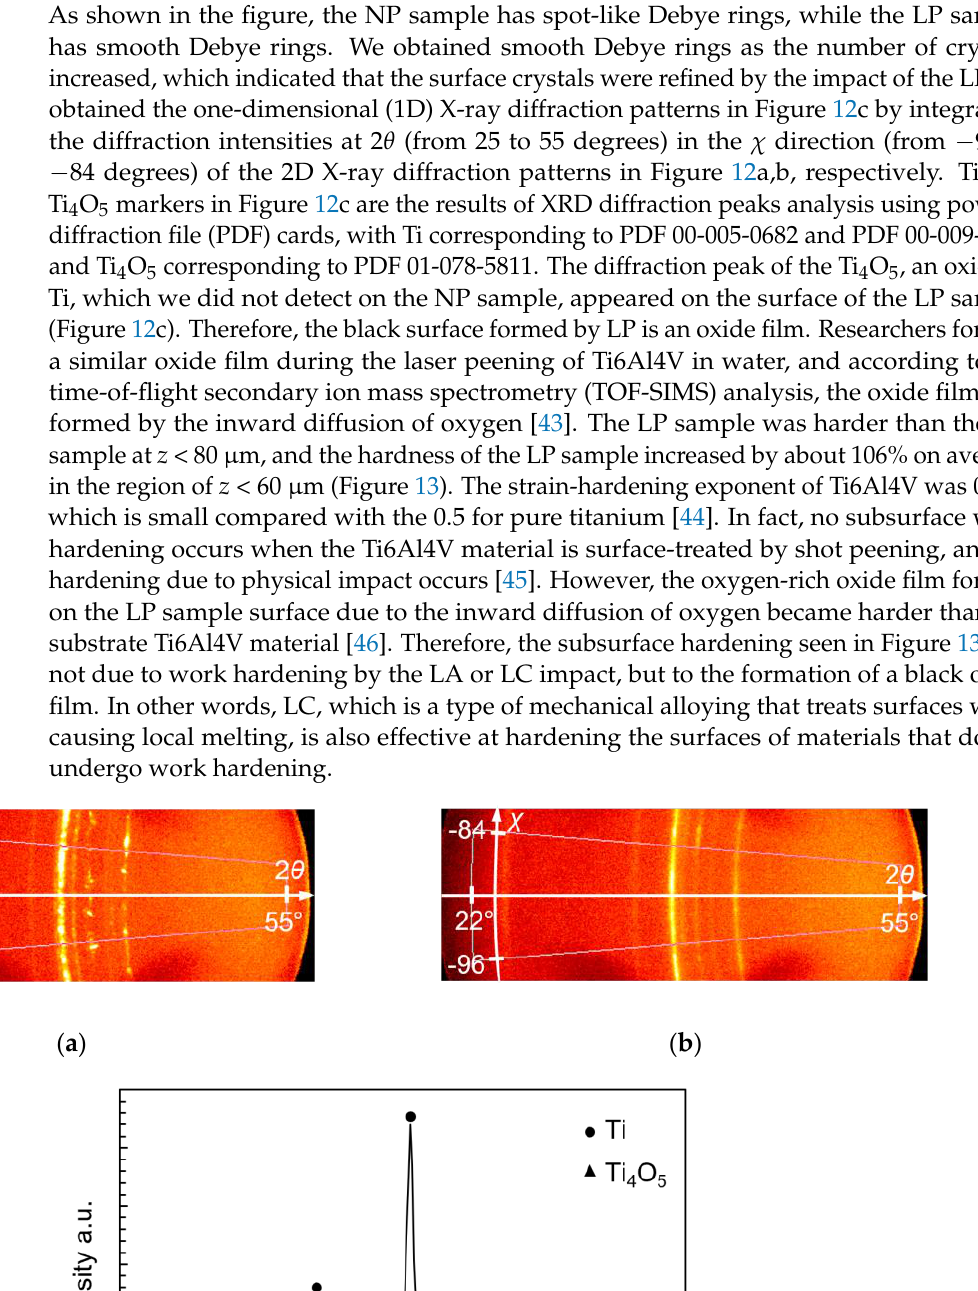
Figure 13. Hardness of cross-sectional area. 3.4. Improvement of Fatigue Life by Laser Cavitation We present the results of the torque-controlled torsional fatigue tests for the NP and LP samples at τ a = 460 MPa, showing the applied stress as a function of the number of cycles to fatigue (S – N curves), in Figure 14. For comparison, we present the same torsional fatigue test results for various surface treatment conditions and for different τ a values [27] from previous fatigue test results. Table 2 shows the sample names and mechanical sur- face treatment conditions in Figure 14. “ NP ” is the untreated specimen (same condition as NP sample ), “SP” stands for shot peening, “CP” stands for water cavitation jet, and “ LP ” stands for submerged laser cavitation peening (same condition as LP sample). The following surface treatment conditions for the SP, CP, and LP were the optimum condi- tions: processing time per unit length ( t p ): 5 s/mm; t p : 4 s/mm; d L : 80 pulse/mm 2 ; stress ratio ( R ): −1 . Additionally, we indicated the direction of the macrocracks formed by the